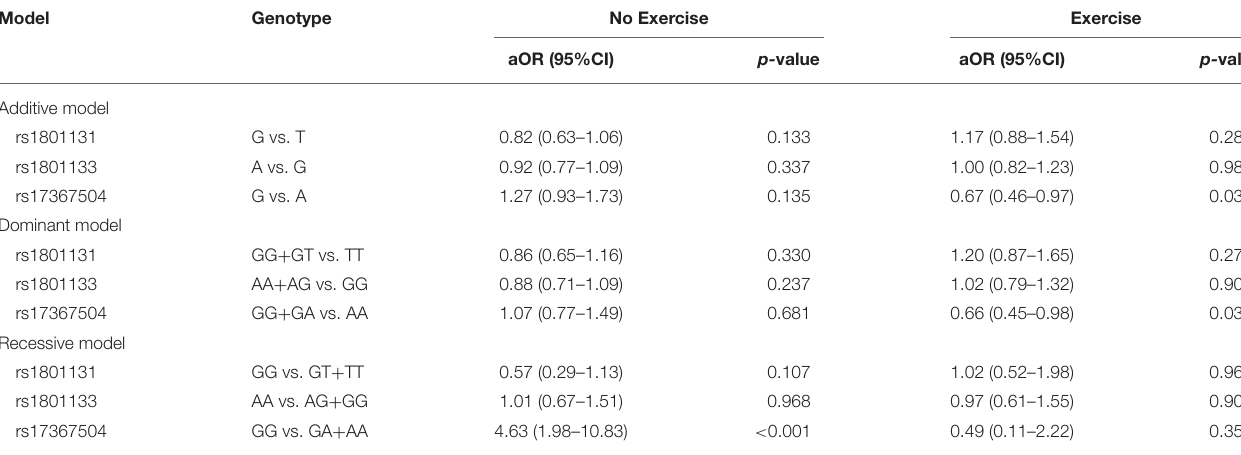
TABLE 5 | Association of SNPs (rs1801131, rs1801133, and rs17367504) with MDD based on additive, dominant, and the recessive models stratified by exercise habits.